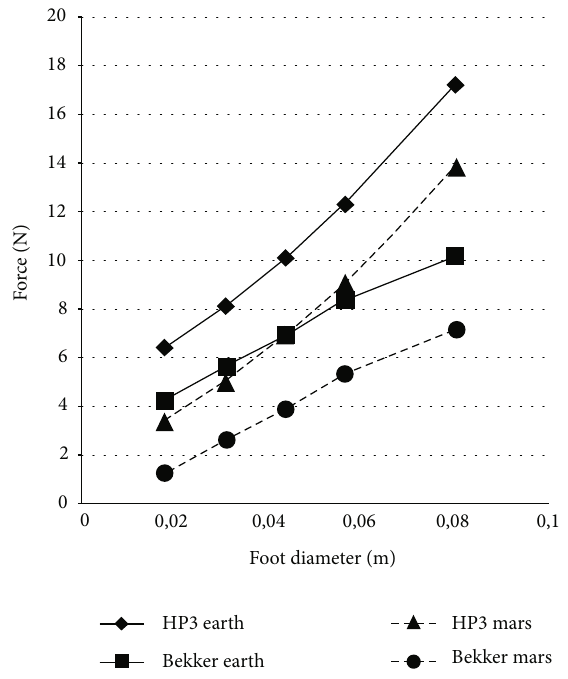
Figure 10: Results of the design